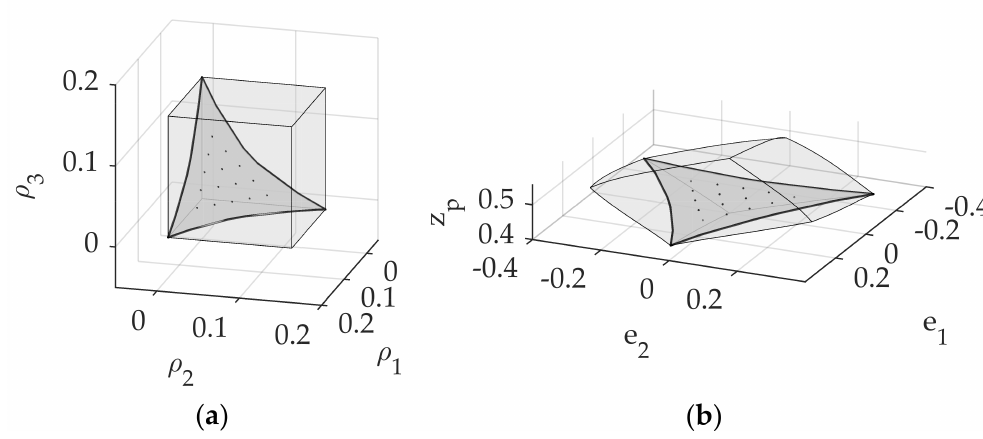
Figure 9. 3 PFS Jointspace transformation to workspace.